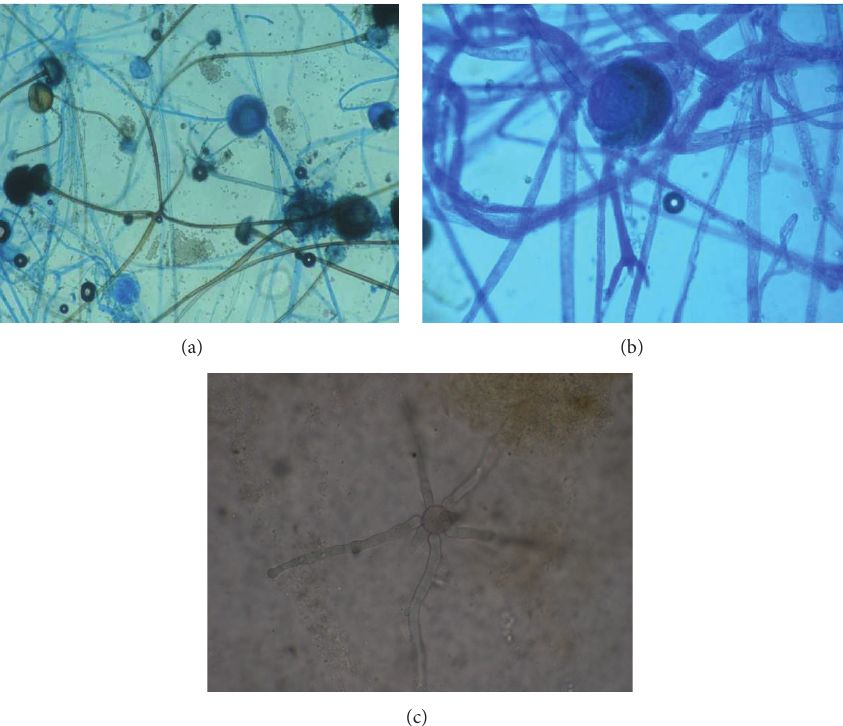
Figure 3: (a) Structural features of Rhizopus species. The sporangiophores (a stalk that arises from the vegetative hypha) and sporangia (asexsual spore-forming structures) are visible as they are rising from stolons opposite to rhizoids. (Lactophenol cotton blue preparation from culture, 40x magnification.) (b) A sporangiophore filled by sporangiospores. (Lactophenol cotton blue preparation from culture, 40x magnification.) (c) KOH preperation of tissue sample shows coenocytic (nonseptated) hypha (40x